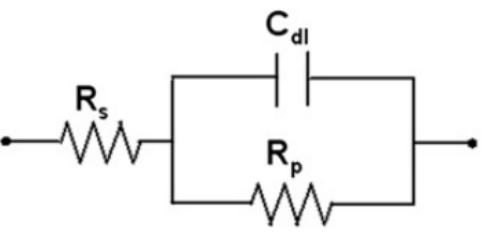
Figure 3. Schematic of a simple electrochemical electrode system.